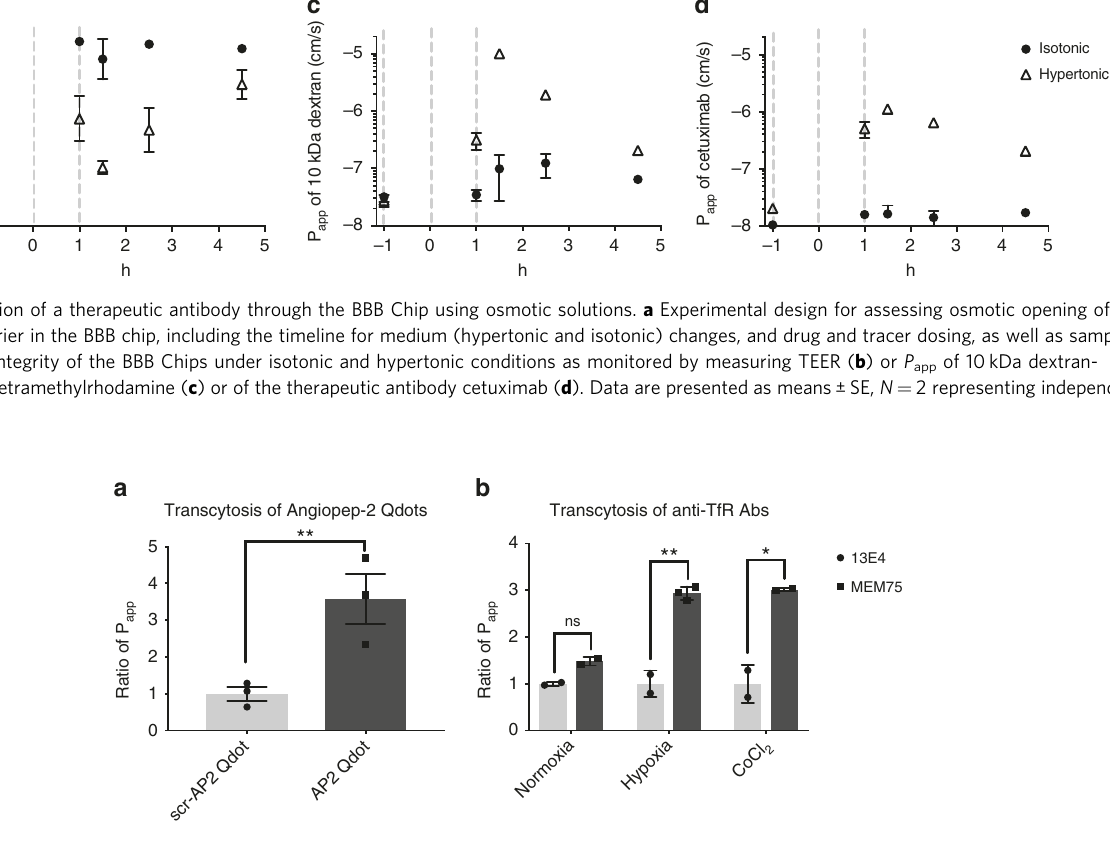
Fig. 5 Recapitulation of Angiopep-2 peptide and anti-TfR antibody shuttling through the BBB on-chip. a Transcytosis of the known BBB shuttle molecule, Angiopep-2, measured by quantifying the Ratio of P app of Angiopep-2-conjugated quantum dot (Q-dot) nanoparticles versus Q-dots coated with a scrambled version of the Angiopep-2 peptide in chips lined by iPS-BMVECs differentiated under hypoxic conditions. N = 3, representing independent BBB Chips. b Ratio of P app of the known BBB-shuttling low-af fi nity anti-TfR antibody MEM75 (dark gray) relative to that displayed by the non-shuttling high- af fi nity anti-TfR 13E4 antibody (light gray) measured in human BBB Chips generated with iPS-BMVECs differentiated under normoxic or hypoxic conditions, or in the presence of CoCl 2 . Data are presented as means ± SE, N = 2 representing independent BBB Chips. The statistical analysis is two-way ANOVA with Tukey ’ s multiple comparisons test; * P < 0.05; ** P < 0.001; *** P < 0.0001